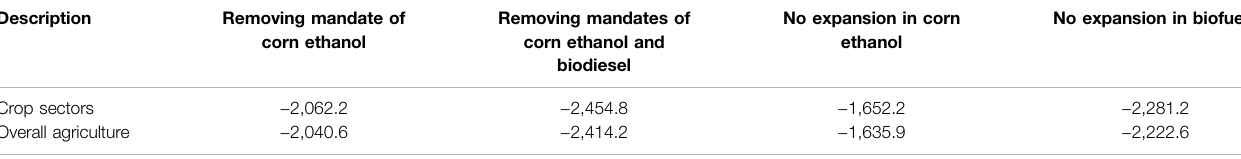
TABLE 6 | Changes in farm income with and without the RFS and biofuel changes for 2011 – 16 (Million USD).